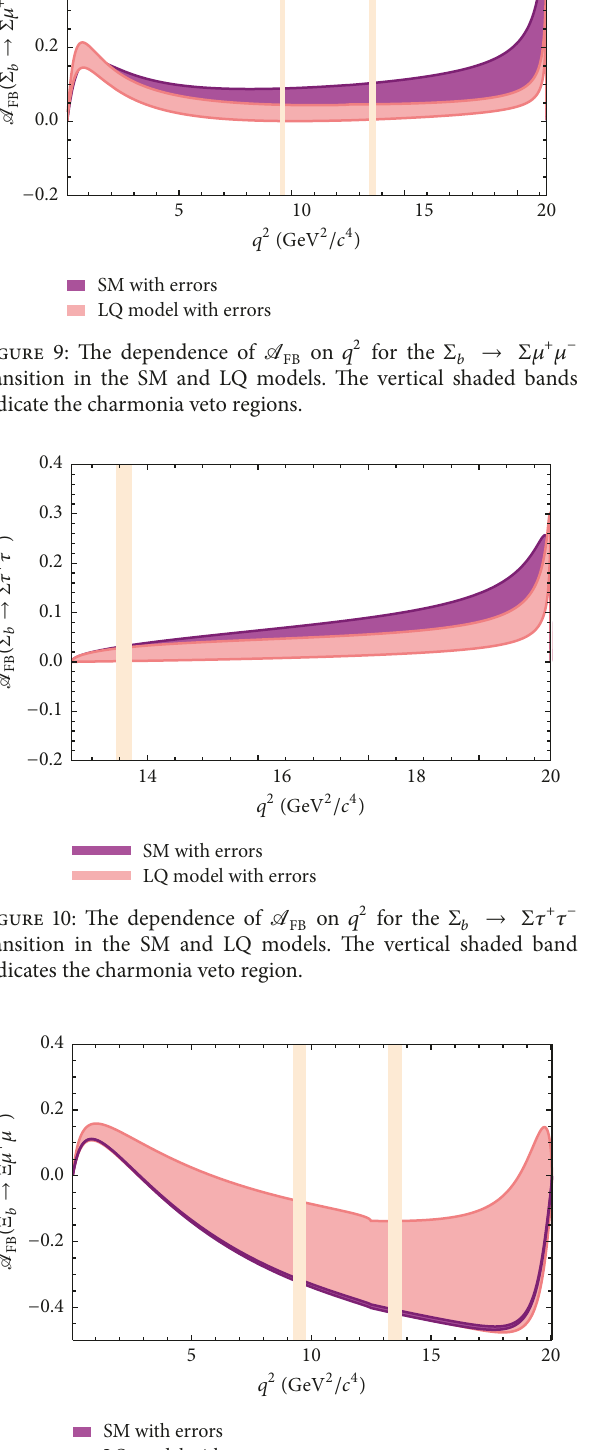
Figure 11: The dependence of A FB on 𝑞 2 for the Ξ 𝑏 → Ξ𝜇 + 𝜇 −